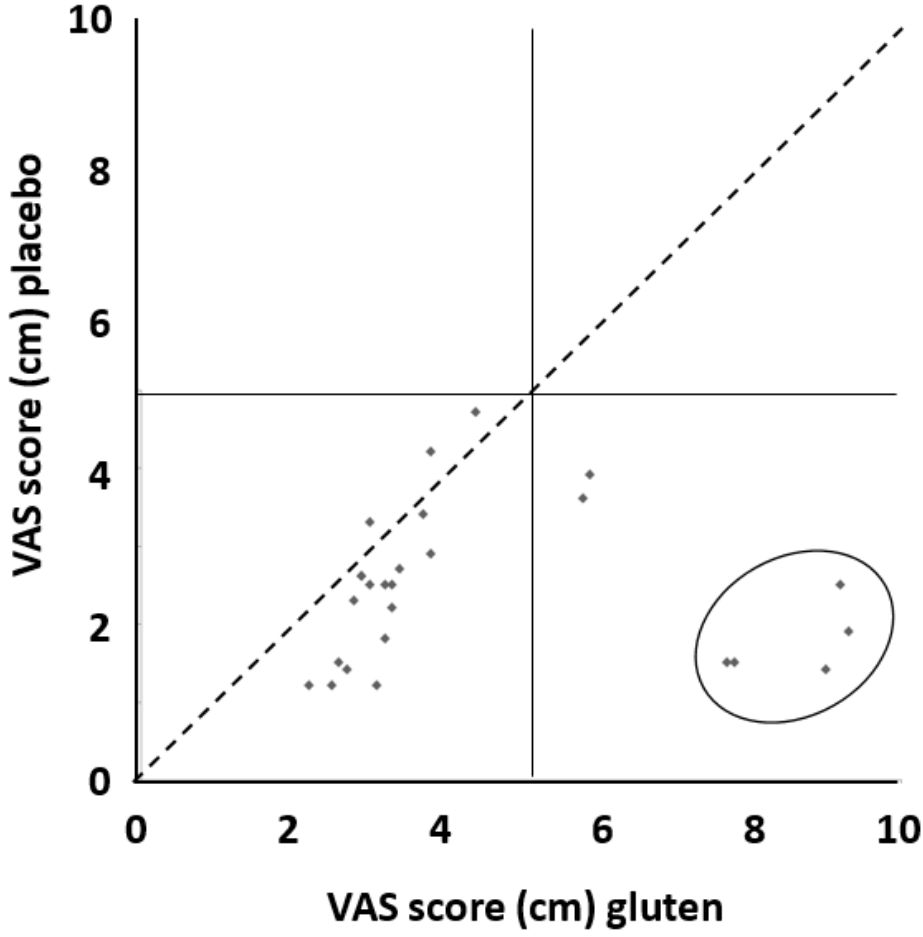
Figure 4. Distribution of patients according to their VAS score while on gluten and placebo. Patients closer to the diagonal dashed line had a similar response to gluten and placebo. The two patients located in the lower right square but not included in the ellipse experienced a mild degree of the overall response. Patients included in the ellipse had a significant increase in VAS score ≥ 5.0 cm after gluten challenge (for the calculation of this value refer to the “Materials and Methods” section). The risk of symptom worsening after gluten assumption was increased by five times (95% CI 0.63 to 39.91) compared to placebo, although such a di ff erence did not reach statistical significance. The absolute risk di ff erence was 15% (95% CI − 1% to